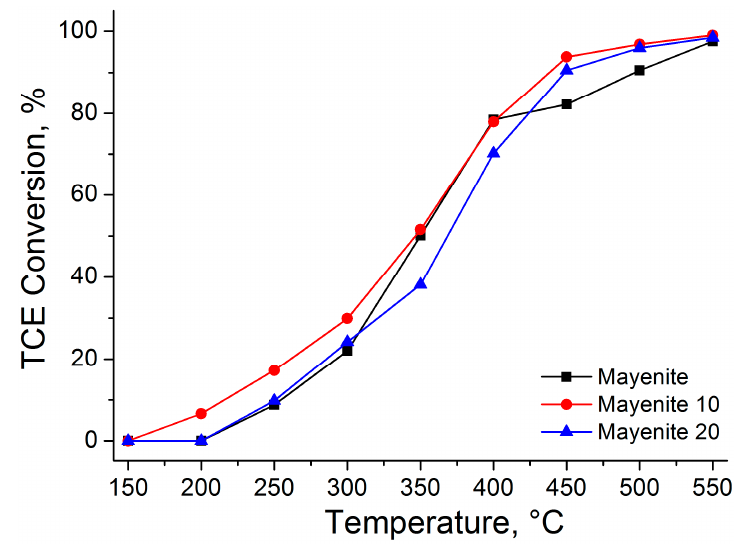
Figure 3. TCE conversion under wet conditions for mayenite (black), mayenite 10 (red), and mayenite 20 (blue). (catalyst = 0.7 g, [TCE] = 1000 ppm, water vapour = 1.7%, flux = 400 mL/min, GHSV = 12,000 h − 1 ). 101